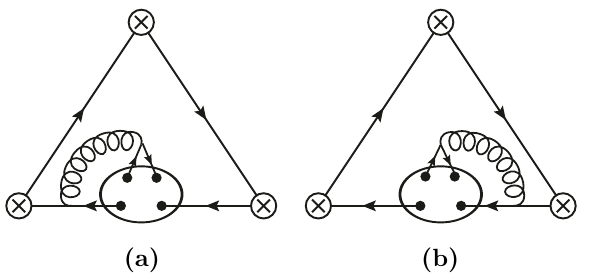
Figure 10. Feynman diagrams of the contributions of the four-quark condensate to the three-point Green functions due to the e(cid:11)ective propagation of the nonlocal quark condensate (8.3).